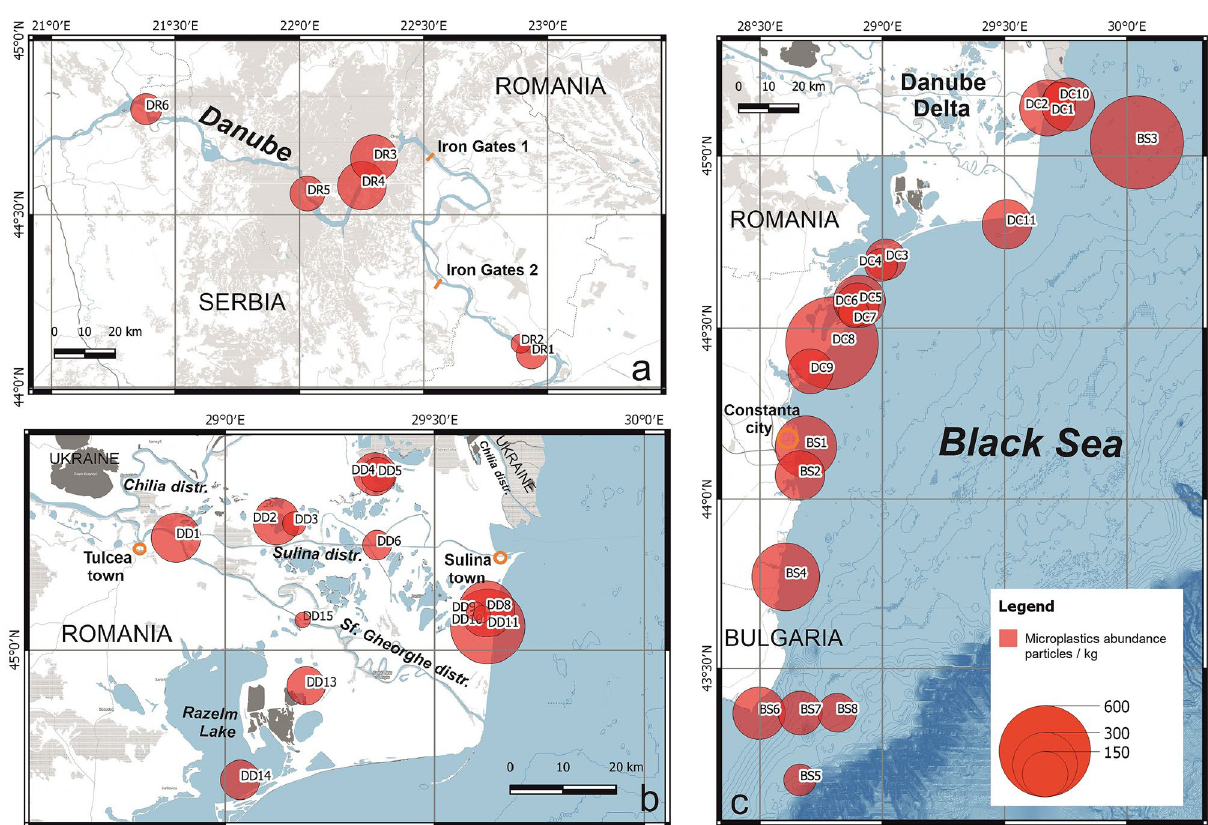
Figure 2. Microplastic particle abundance on: ( a ) the Danube River (Iron Gates area); ( b ) Danube Delta; and ( c ) Black Sea coast and inner shelf. The concentration is calculated for particles per 1 kg of sediment. (Figures created with the assistance of Cornel Pop, GeoEcoMar, using QGIS 3.4, background data: www.OpenS treet map. org and https ://land.coper nicus